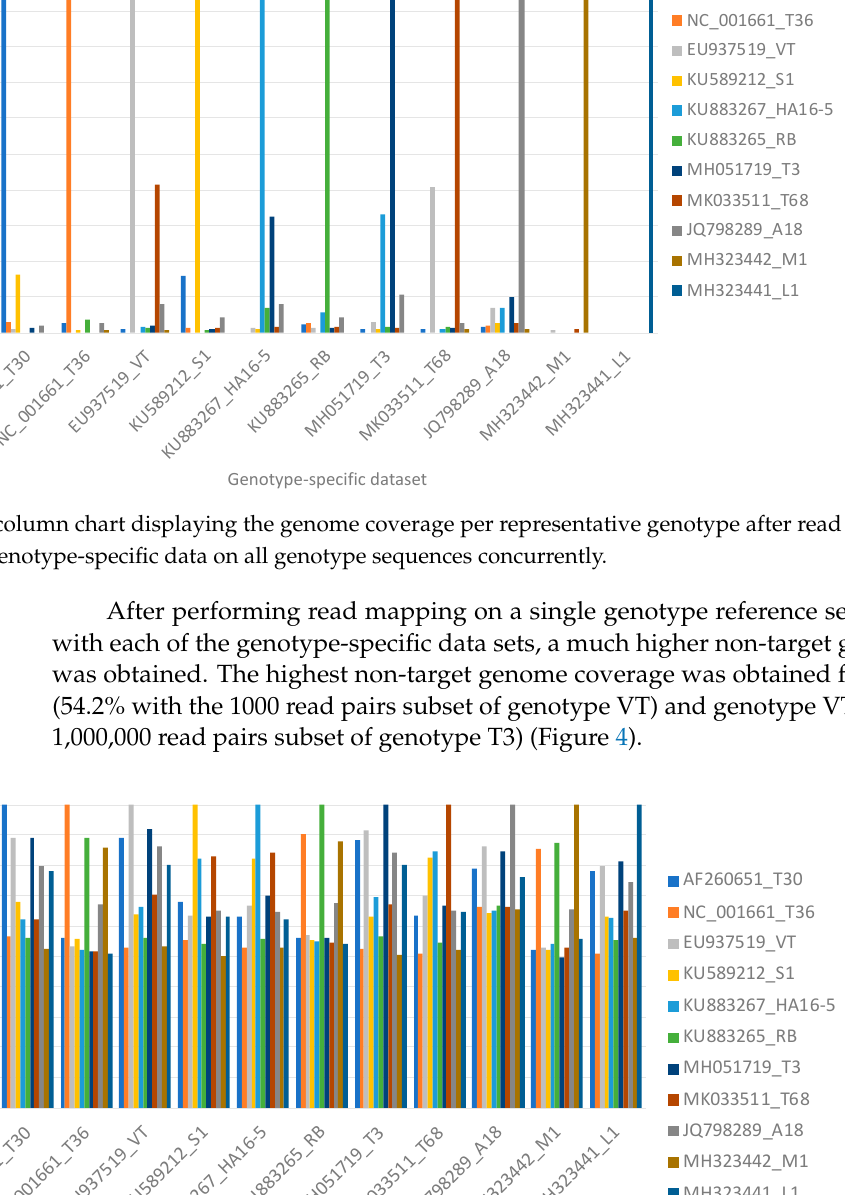
Figure 4. A clustered column chart displaying the genome coverage per representative genotype after read mapping one million read pairs of genotype-specific data on each of the genotype sequences individually.